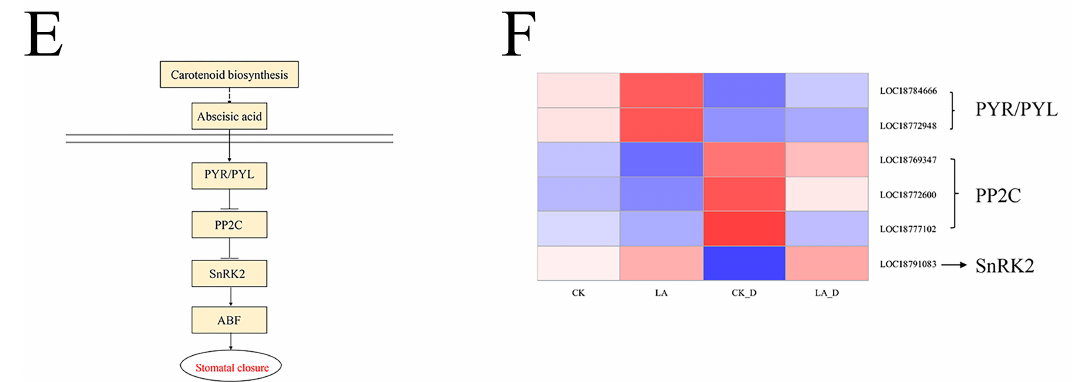
Figure 9. Effects of exogenous LA on hormone signaling in drought-stressed P. persica . Transduction of plant hormone signals in response to exogenous melatonin administration ( A , C , E ). Gene expression profiles for the signaling pathway for plant hormones ( B , D , F ). The expression levels were assessed by log2-transformed FPKM values.